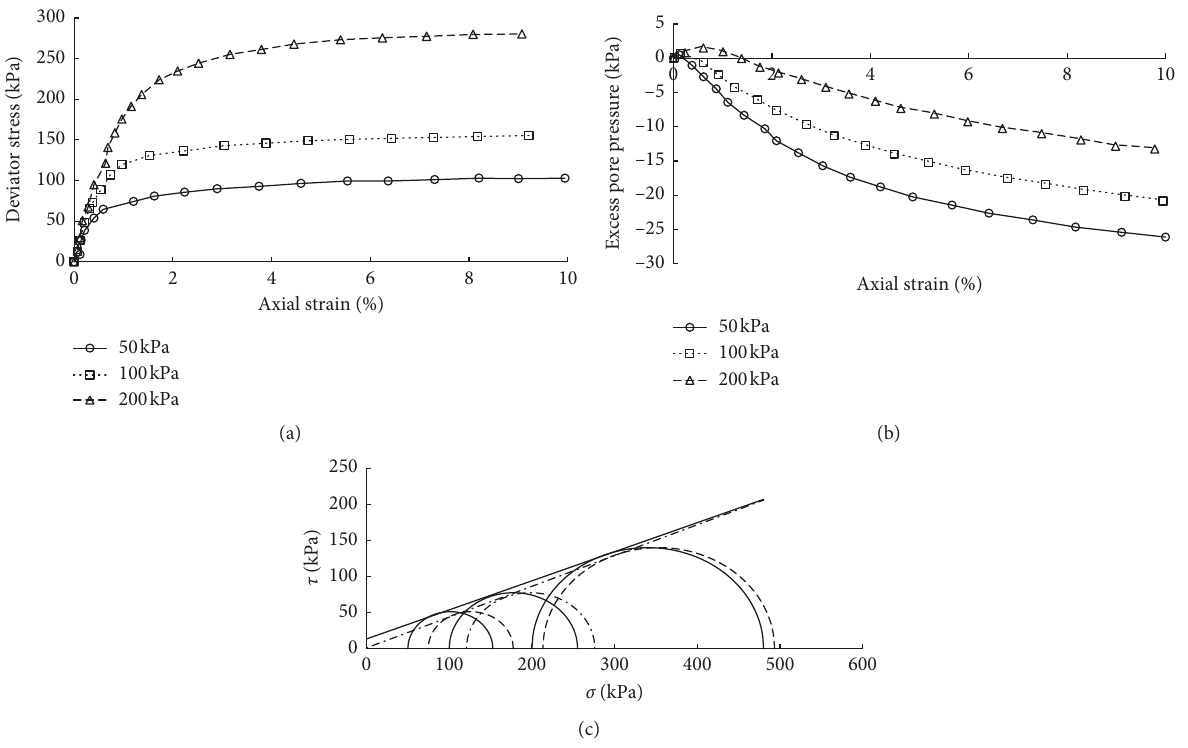
Figure 11: Results from consolidation-undrained triaxial shear test: (a) stress-strain curves; (b) variation in excess pore pressure with shearing strain; (c) Mohr circle.